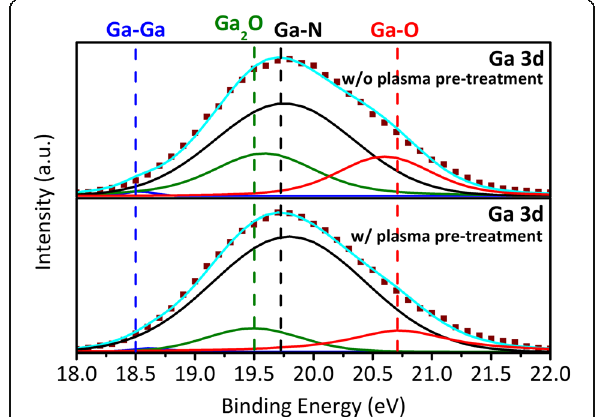
Fig. 4 XPS spectroscopy of Ga 3d peak at the interface between AlN and AlGaN for HEMTs without (Upper) and with (under) plasma pre- treatment. The spectrum was fitted by Gaussian function and sepa-